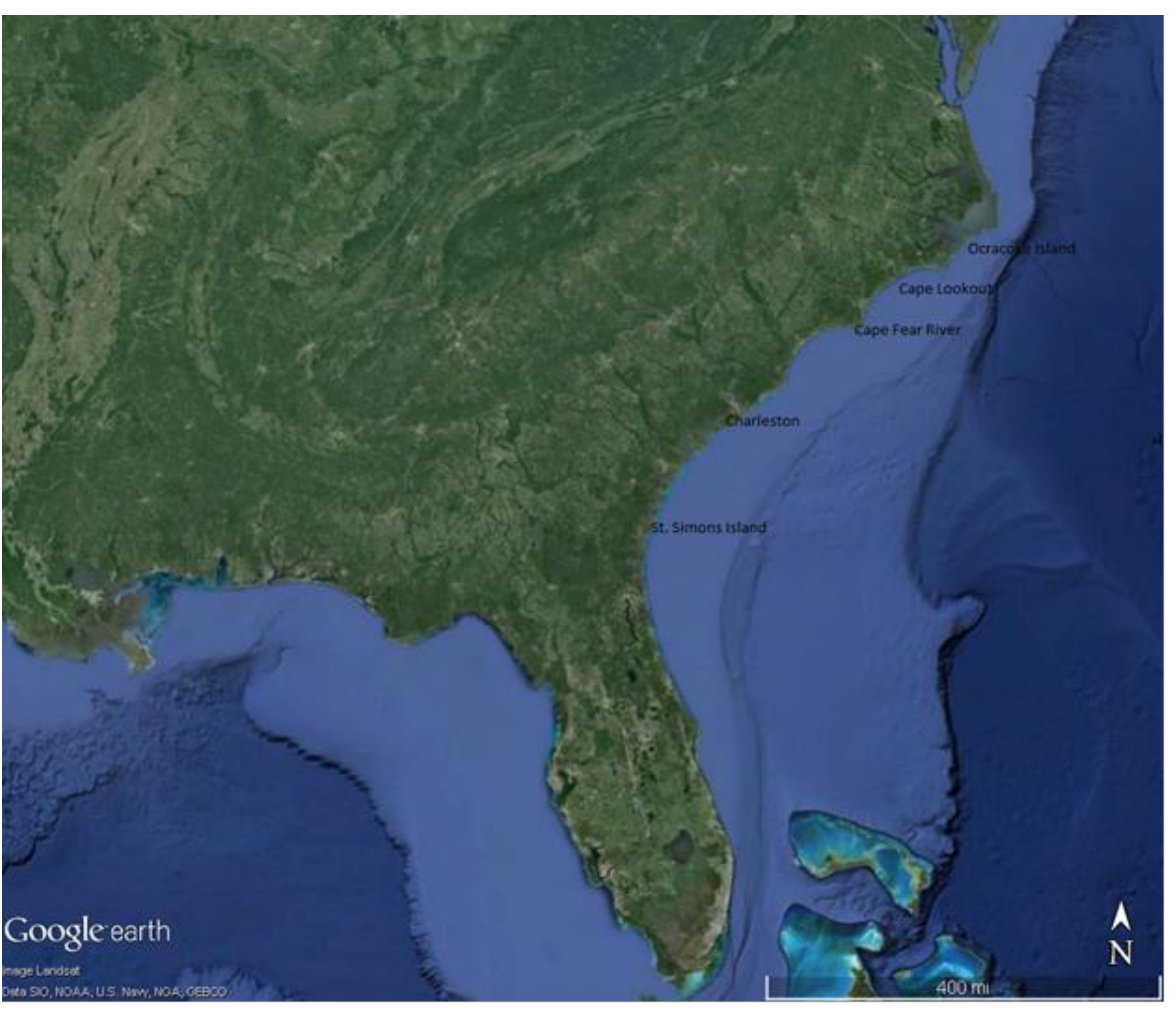
Figure 1. Map of the Coastal Carolina